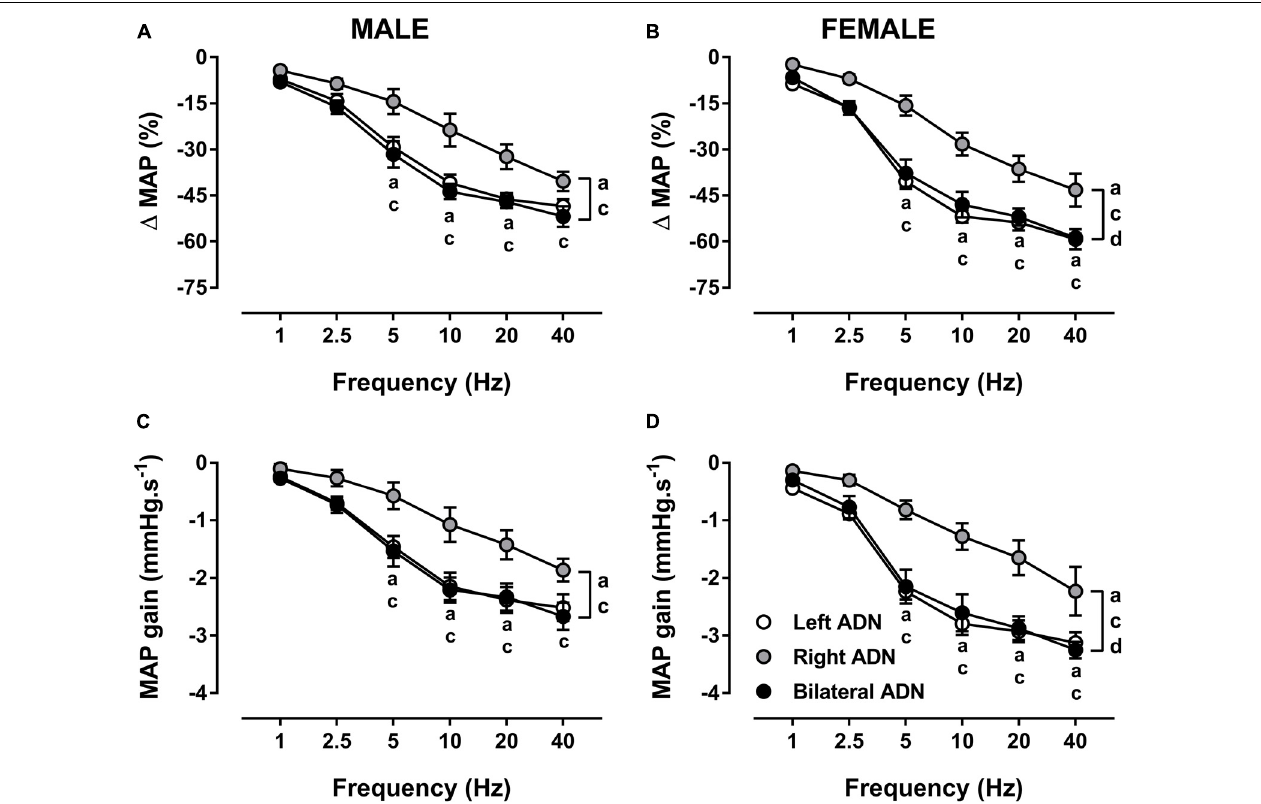
FIGURE 3 | Effects of left, right and bilateral aortic depressor nerve (ADN) stimulation (1–40 Hz, 0.4 mA, 0.2 ms, 20 s) on mean arterial pressure (MAP) (A,B) and MAP gain (C,D) responses in urethane-anesthetized male (left panels) and female (right panels) Sprague Dawley (SD) rats ( n = 7–11). Results are expressed as mean ± SEM. a P ≤ 0.05, left vs. right ADN, c P ≤ 0.05, right vs. bilateral ADN and d P ≤ 0.05, female vs. male for respective left and bilateral ADN analyzed by a two-way ANOVA followed by Bonferroni’s post hoc . Note that, in males and females, left and bilateral stimulation evoked greater drops (both overall and at frequencies of 5–40 Hz) in MAP and MAP gain compared to right-sided stimulation. Females’ left and bilateral stimulation displayed greater reflex changes in MAP parameters compared with those of the males’ counterpart.